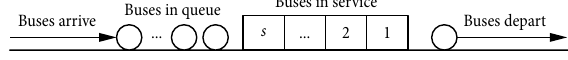
Fig. 5. The process of passenger serving at bus stop